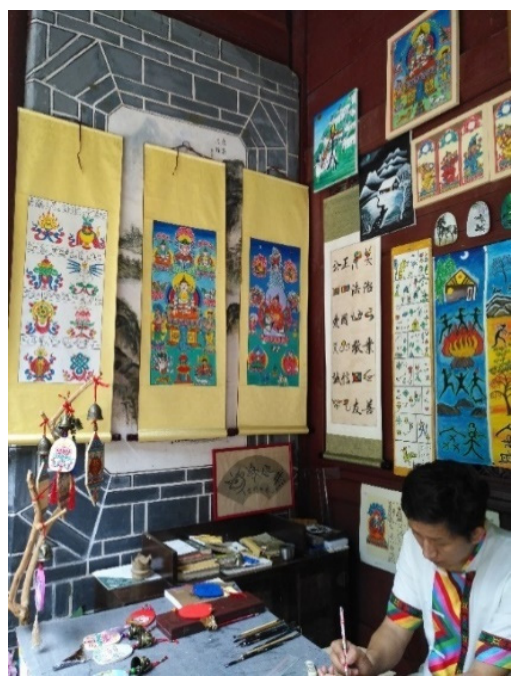
Figure A1. Performer working at scenic spot, drawing traditional paintings.